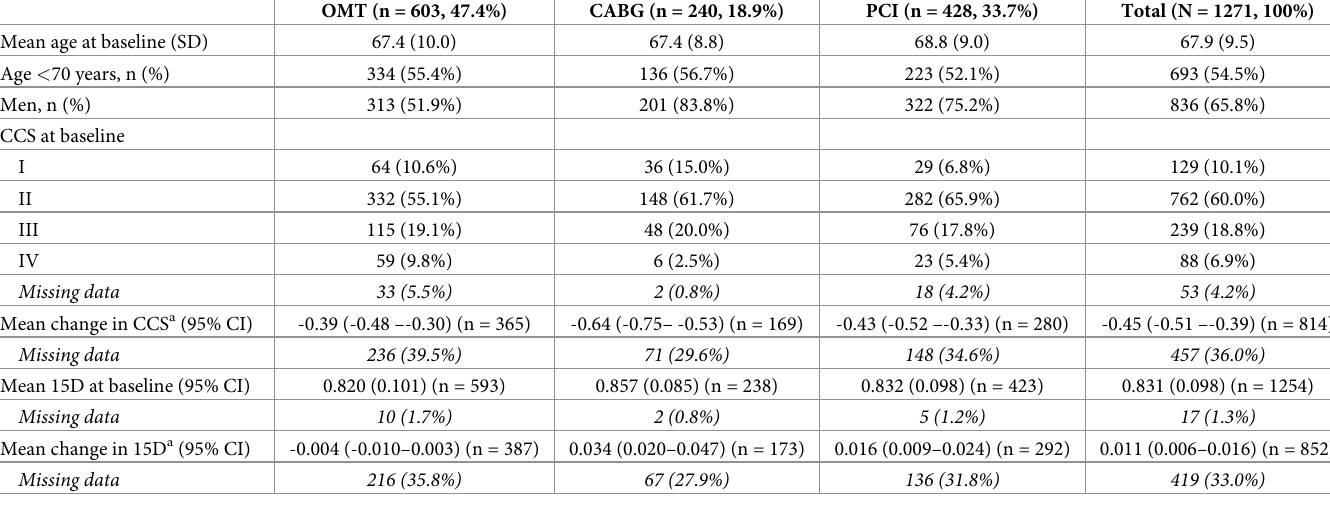
Table 2. Participant